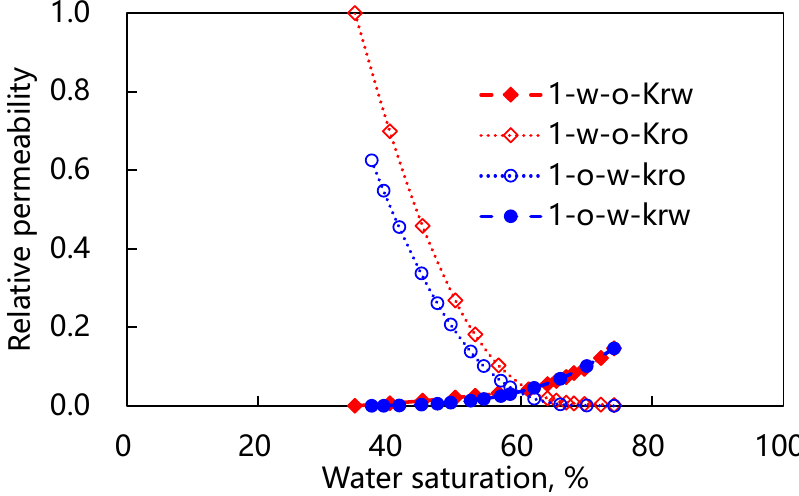
Figure 1. Oil/water permeability plot of relative mutual drive.